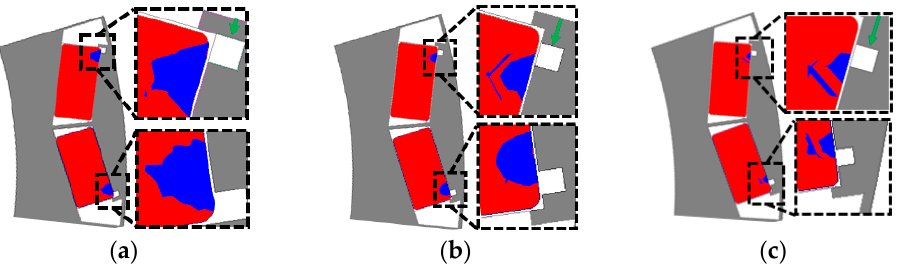
Figure 14. Irreversible demagnetization region with different air hole positions toward the bridge: ( a ) 0 mm, ( b ) 0.6 mm, ( c ) 1.2 mm.